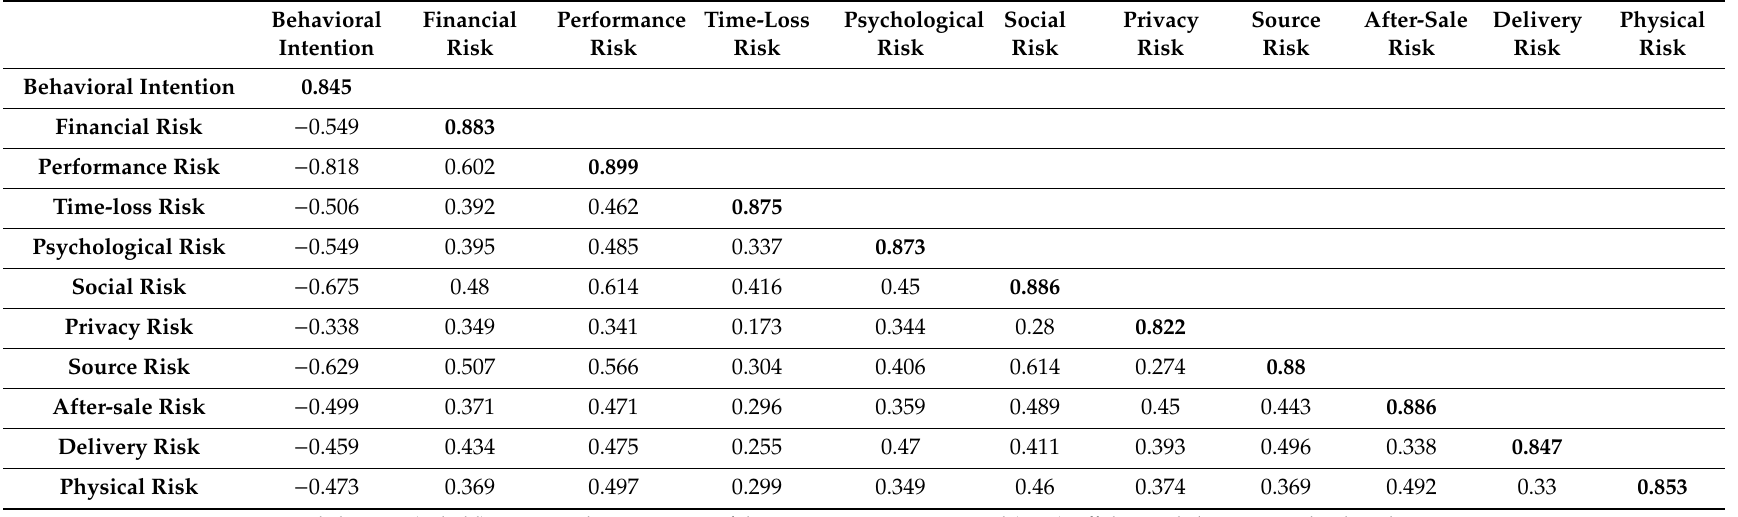
Table A3. Discriminant validity